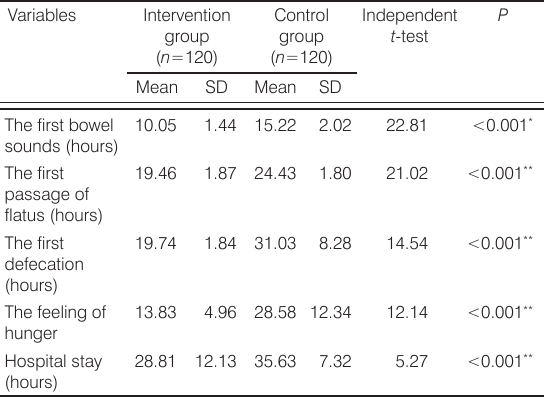
Table 4. Postoperative parameters in both groups. Note: * Statistically significant difference ( P < 0.05);** Highly statistically significant difference ( P < 0.001).